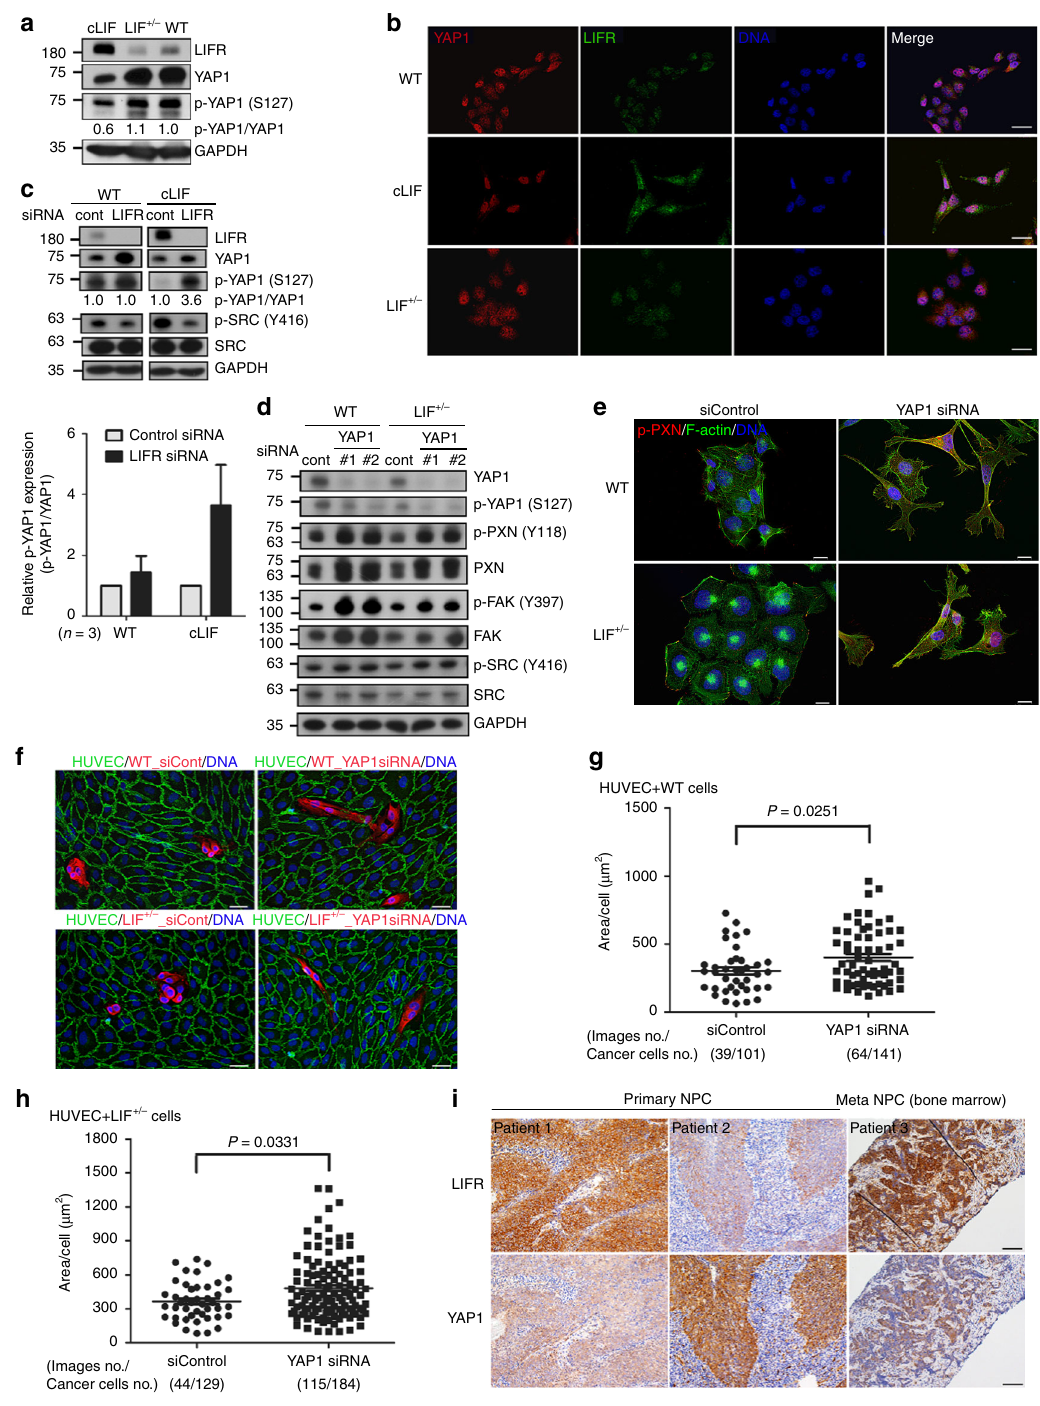
Fig. 6 LIFR – YAP1 signaling is critical for LIF-mediated invasion of NPC cells. a Endogenous protein expression of LIFR, p-YAP1(S127), and YAP1 in three cancer cell lines. b Immunostaining for YAP1 and LIFR in three cancer cell lines. Scale bars, 10 μ m. c Western blot analysis of LIFR and p-YAP1 (S127) protein levels in WT and cLIF cancer cells transfected with SMARTpool LIFR siRNA or control siRNA. The p-YAP1 (S127) expressions with respect to total YAP1 levels were quanti fi ed and presented as mean ± SEM ( n = 3). At least three independent experiments were performed. d Western blot analysis of expression of focal adhesion molecules and SRC in WT and LIF + / − cancer cells transfected with YAP1 siRNA. GAPDH was used as the loading control. e Representative images for p-PXN (Y118) expression in WT or LIF + / − cancer cells transfected with YAP1 or control siRNA ( n = 3). Alexa Fluor 488 phalloidin (green) was used to stain F-actin. Scale bars, 10 μ m. f Representative images of the HUVEC layer replacement assay. Fixed numbers of WT or LIF + / − cancer cells transfected with YAP1 or control siRNA were plated onto the con fl uent HUVEC layer and co-cultivated for 24 h. Cancer cells were labeled with antibody against pan-cytokeratin (red) and HUVEC cells with antibody against VE-cadherin (green). Scale bars, 20 μ m. g , h Quanti fi cation of displaced areas depicted in f . WT cancer cells ( g ). LIF + / − cancer cells ( h ). Invaded areas were calculated using CellSens imaging software (Olympus). Data are presented with scatter dot plot (mean± SEM). Each black dot represents one captured image. Mann – Whitney test. i Immunohistochemistry for LIFR and YAP1 expression (brown) in consecutive NPC biopsy sections derived from primary or bone marrow metastatic